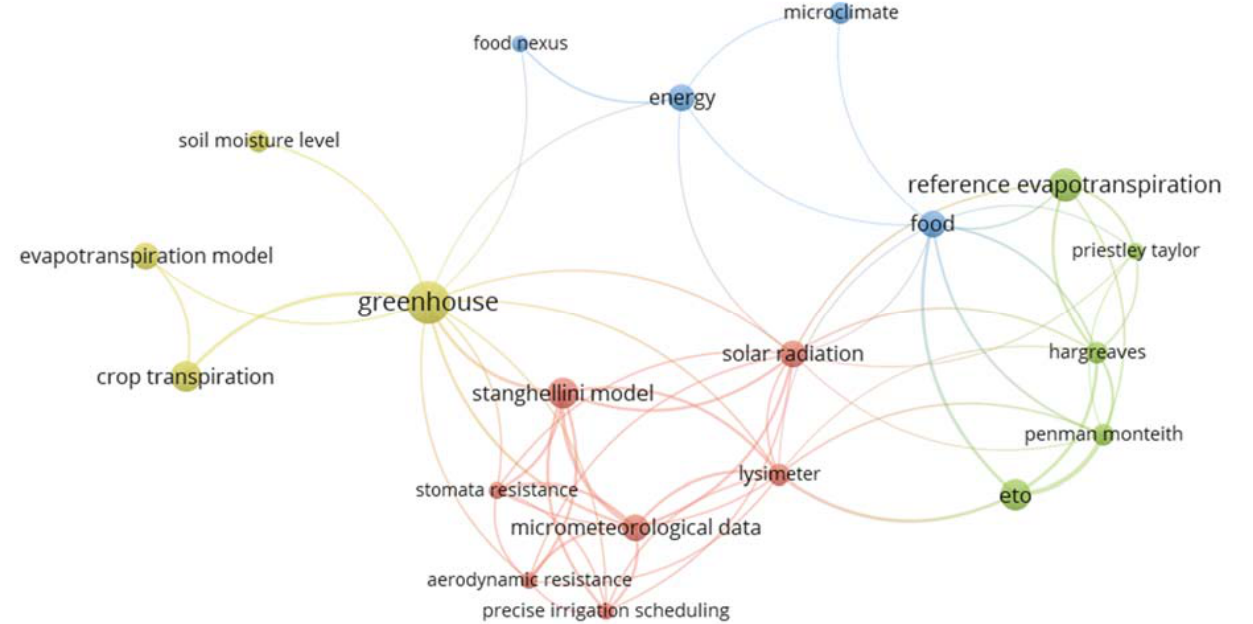
Figure 2. Network visualisation of search keywords.